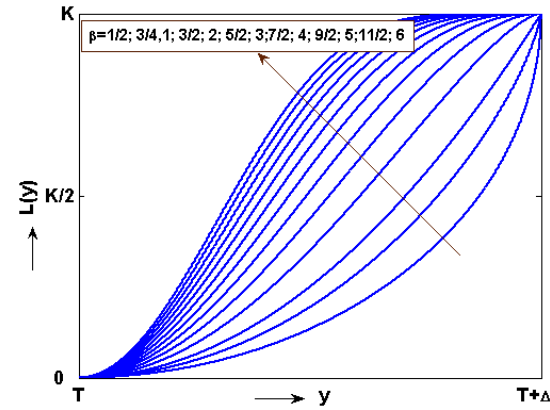
Figure 5. The appearance of the PLF depends on the shape parameter values (only for the right-hand